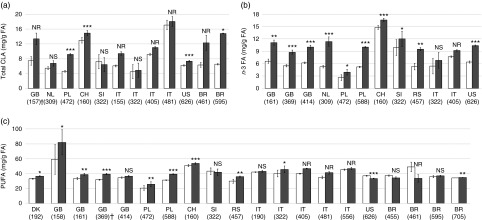
Summary of data presented in papers included in the standard meta-analysis for
concentration of (a) total conjugated linoleic acid (CLA), (b) n-3
fatty acids (FA) and (c) PUFA content in cows’ milk. Values are means with, their
standard errors for conventional () and organic
() production system. Significant
correlation: * P≤0·05; ** P≤0·01; ***
P≤0·001; NS not significant; NR not reported.
On x-axis country code according ISO 3166-2 (see http://www.iso.org/iso/home/standards/country_codes.htm)
and study ID in parentheses (see the online Supplementary Table S1 for references).
† Paper not included in standard meta-analysis for which values for measures of
variance were obtained directly from authors.